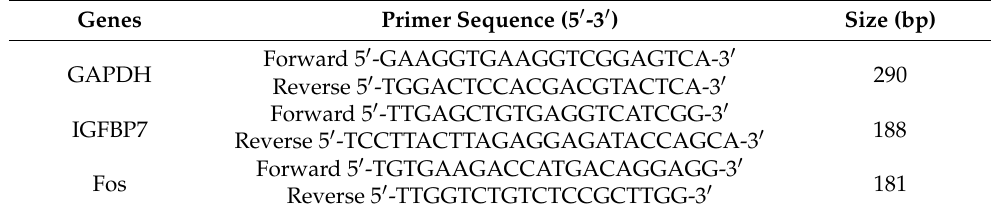
Table 1. Primer sequences for real-time qPCR.